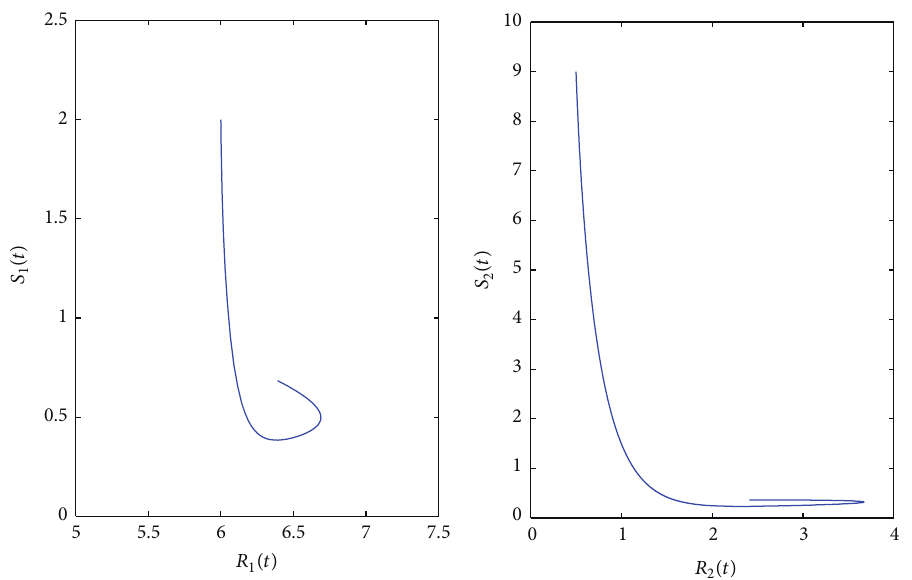
Figure 5: The relation between 𝑆 𝑘 and 𝑅 𝑘 for the deterministic SIRS model.